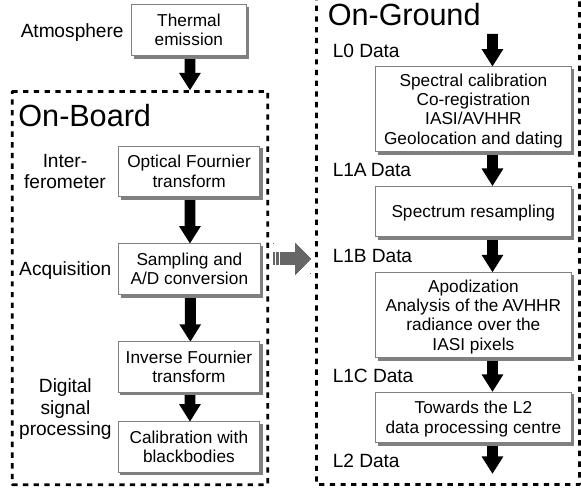
Figure 4. Main stages in the IASI data